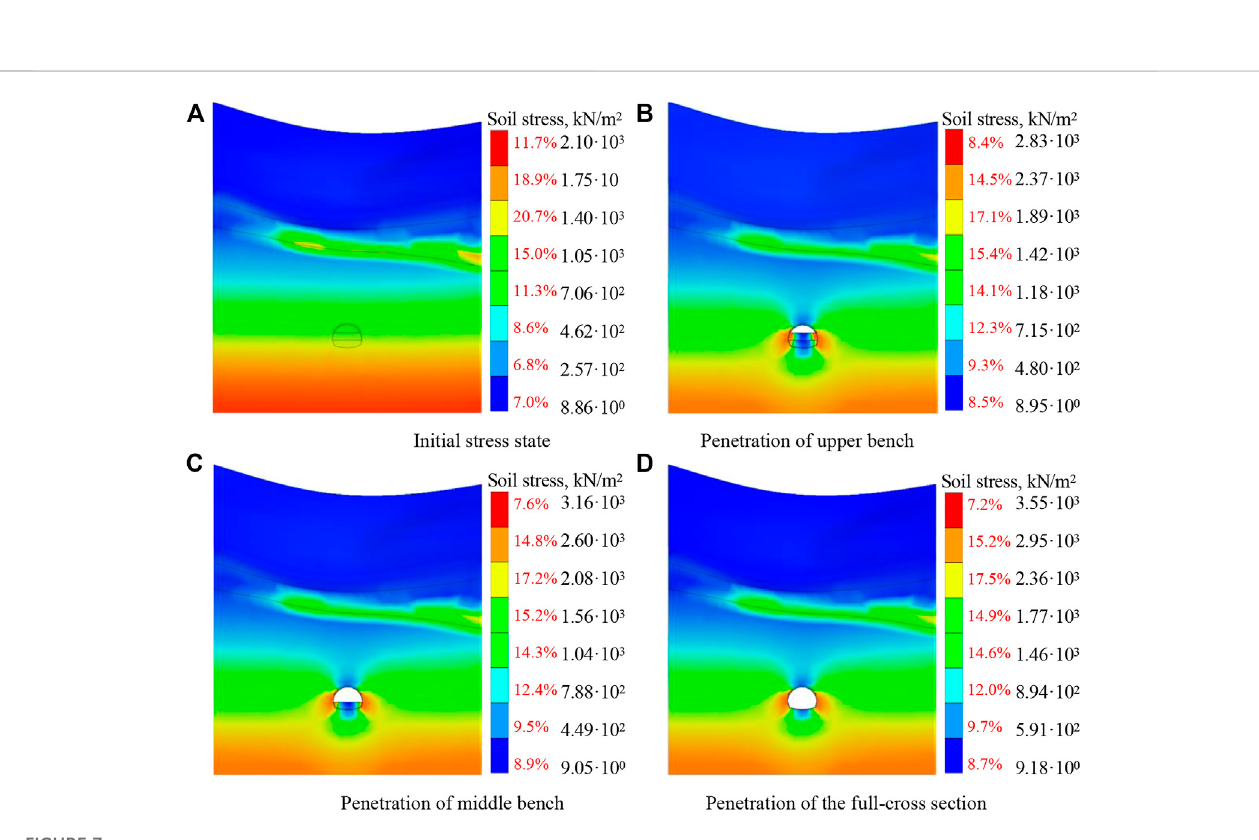
Frontiers in Earth